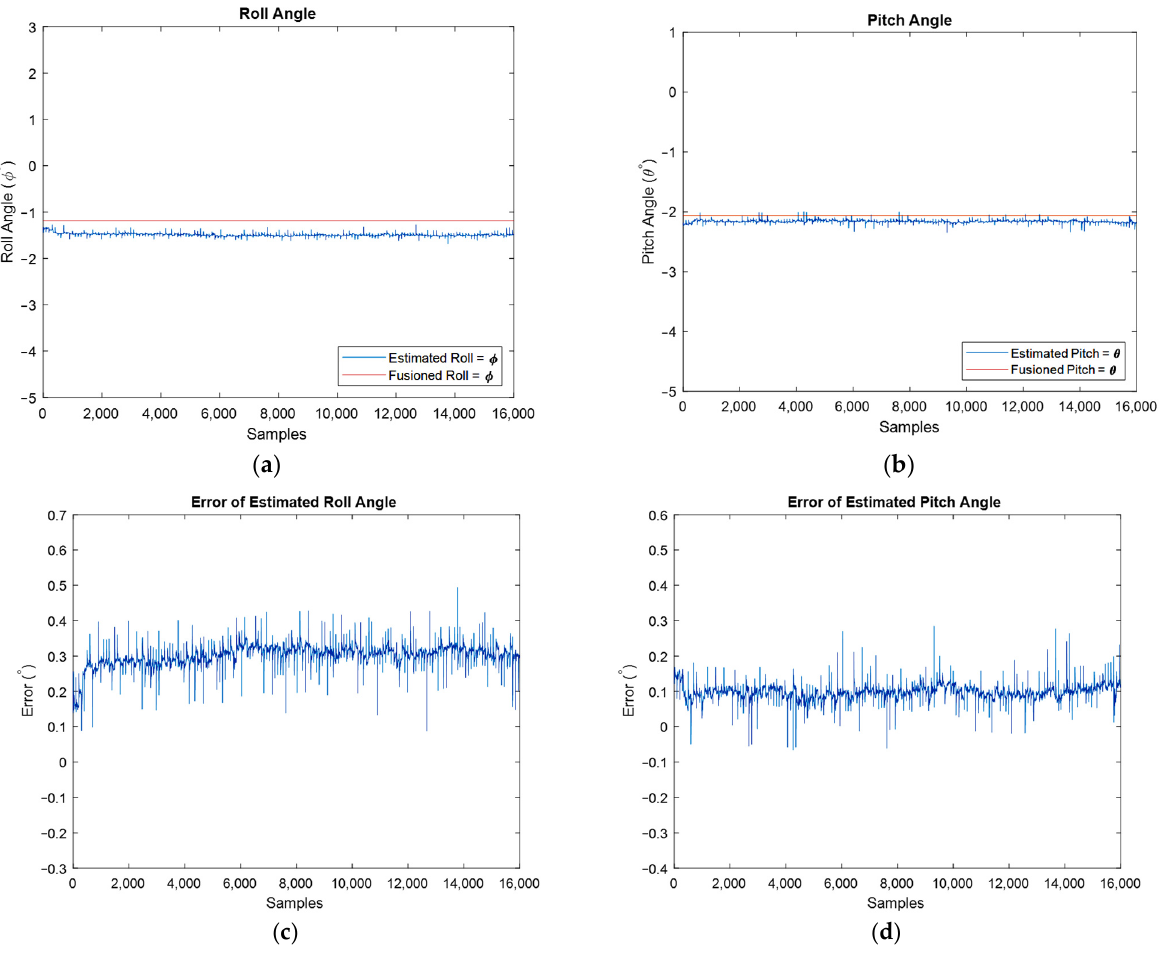
Figure 18. Estimated roll ( a ) and pitch angles ( b ) against filtered IMU output, and estimation error for roll ( c ) and pitch ( d ) angles.